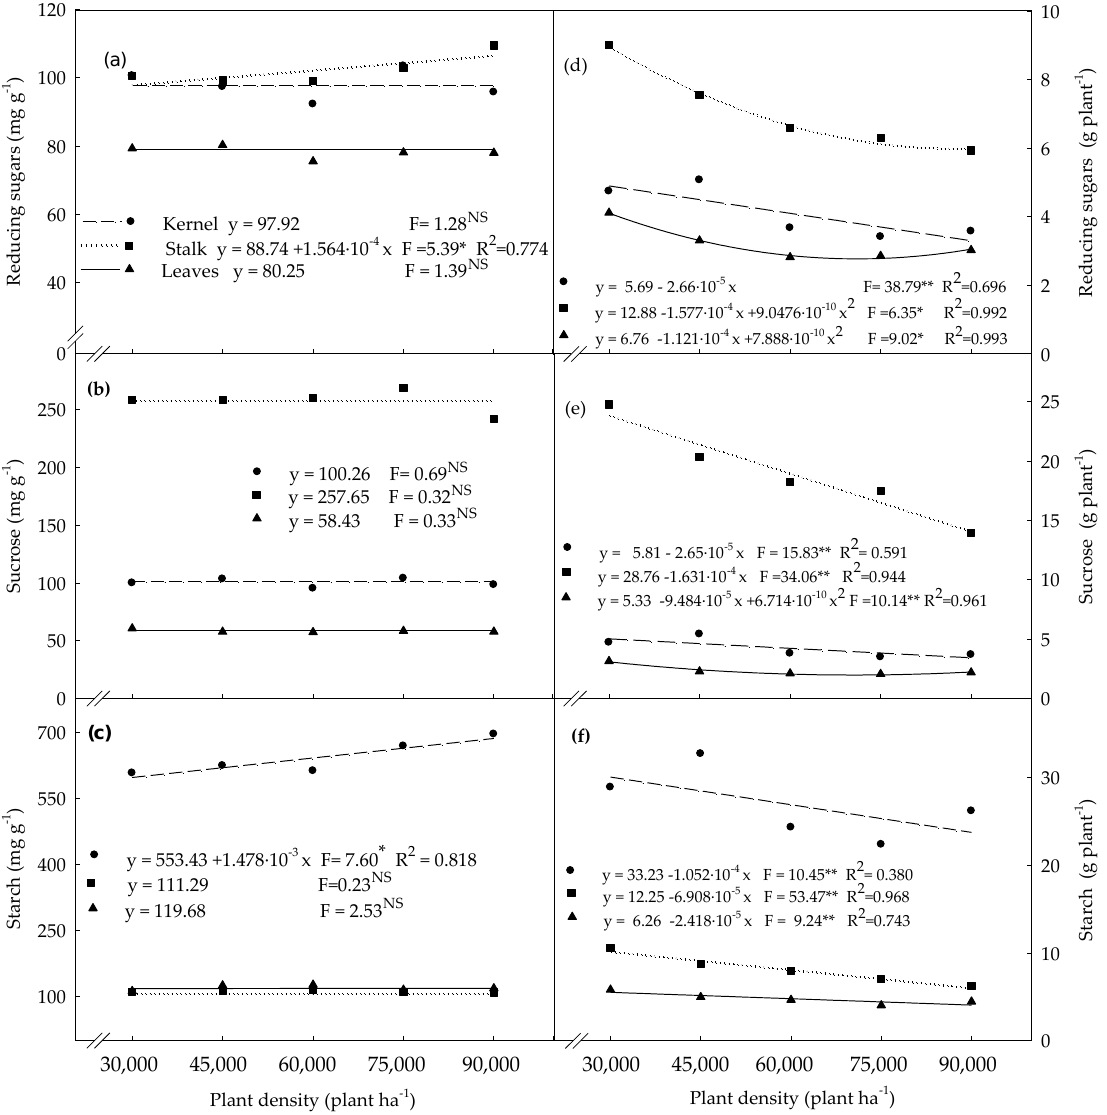
Figure 3. Concentration of reducing sugars ( a ), sucrose ( b ), and starch ( c ), and the amount per plant of reducing sugars ( d ), sucrose ( e ), and starch ( f ) in the kernel, leaf, and stalk of corn plants at the R4 stage, as a function of the plant density, ranging from 30,000 to 90,000 plants per hectare. Statistical data were obtained from four field replications. F = F test result of the regression analysis; (*) and (**) indicate that the F test revealed statistical significance at p ≤ 0.05 and p ≤ 0.01, respectively; R 2 = determination coefficient.